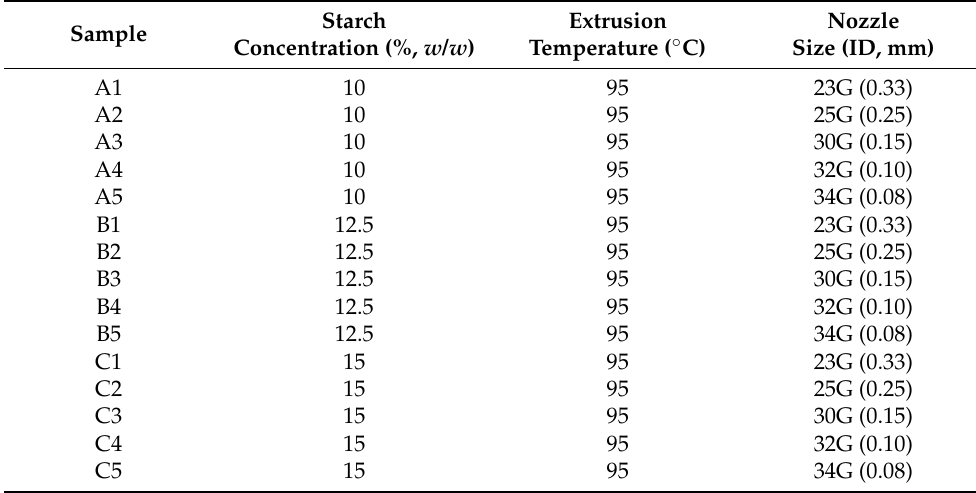
Table 1. The 3D food printing